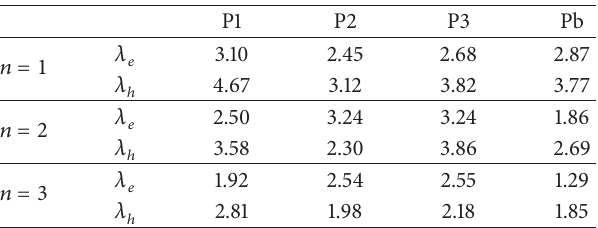
Table 5: Calculated molecular reorganization energies of four molecules ( × 10 − 1